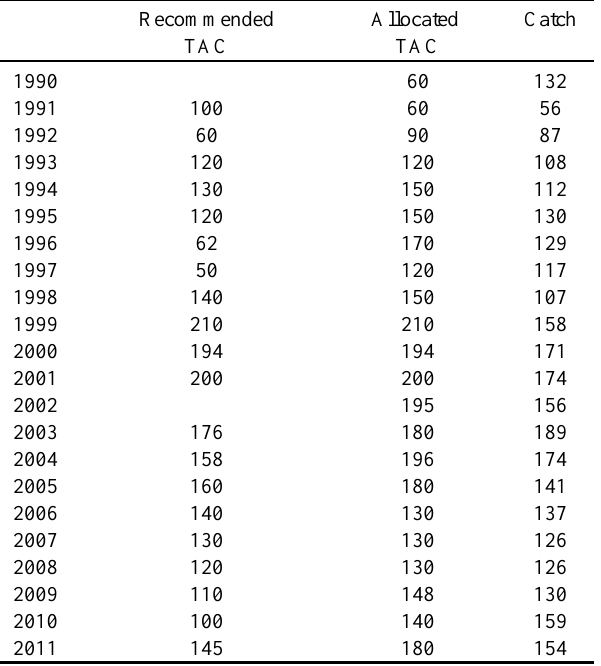
Table 1 . Scientifically recommended total allowable catch (TAC), allocated total allowable catch, and catch, in 1000 tonnes. Data provided by the Ministry of Fisheries and Marine Resources (MFMR) of